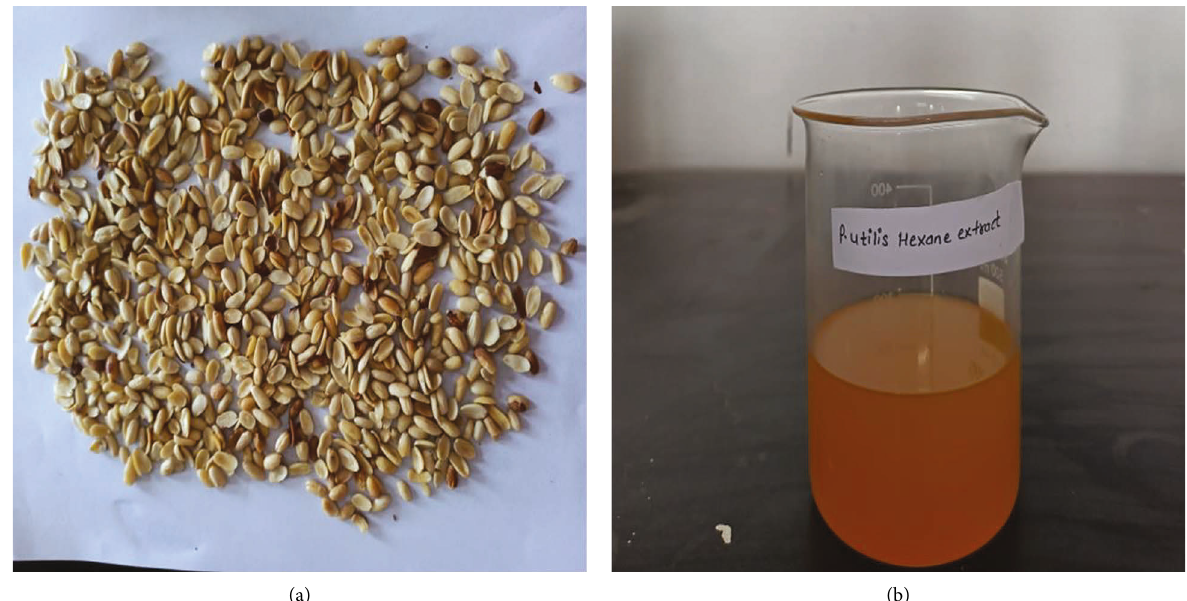
Figure 2: P. utilis plant samples. (a): dried seed kernels; (b) hexanolic extract of seed kernel.